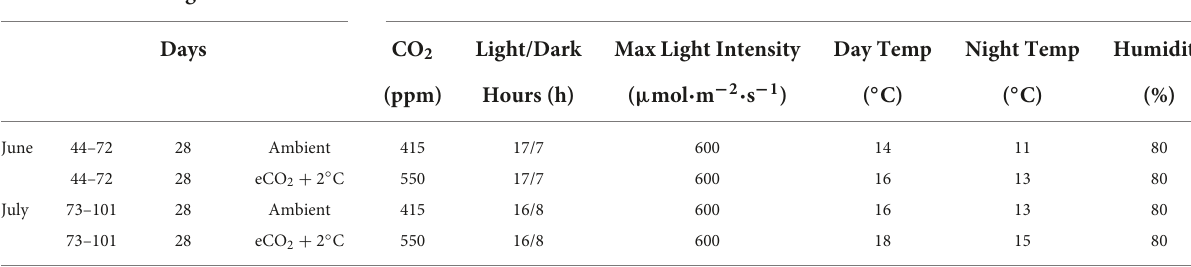
TABLE 1 Experimental Growth Chamber setup for the two ambient and the two climate chambers simulating the months June and July in North-western Europe.